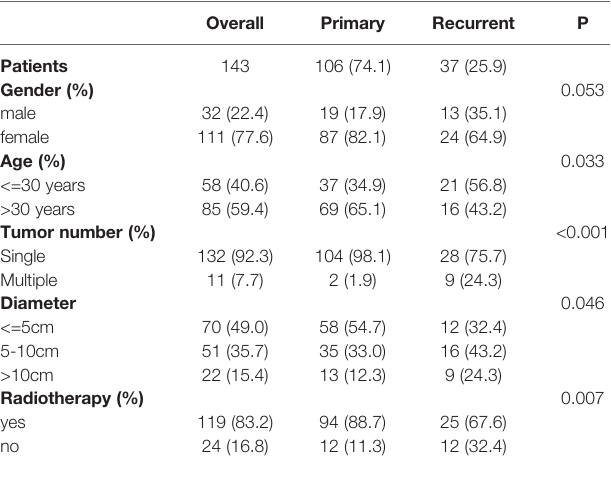
TABLE 3 | Patient demographics and tumor characteristics in the validation